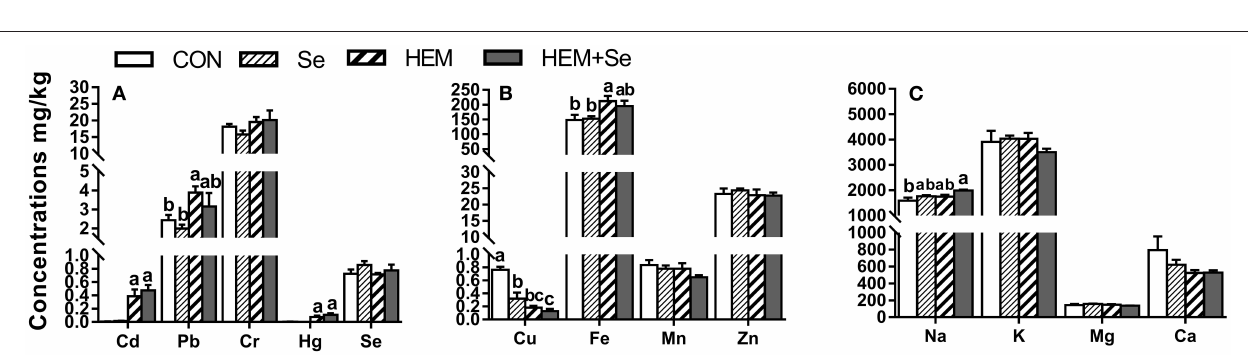
FIGURE 3 | The effect of selenium and cadmium, lead, mercury, chromium Co-treatment on the concentrations of ions in the ovary (Wet Basis mg/kg) of laying hens from 63 to 74 wk of age. CON, corn-soybean meal basal dietary; Se, the basal dietary supplemented with 0.4 mg/kg selenium from selenized yeast (the selenium concentration was 0.14 mg/kg in the CON diet); HEM, the basal dietary supplemented with 5 mg/kg cadmium from CdCl 2 , 50 mg/kg lead from Pb(NO 3 ) 2 , 3 mg/kg mercury from HgCl 2 and 5 mg/kg chromium from CrCl 3 ; HEM + Se, the HEM dietary supplemented with 0.4 mg/kg selenium from selenized yeast. (A) The effect of selenium and cadmium, lead, mercury, chromium Co-treatment on the concentrations of cadmium, lead, chromium, mercury, selenium in the ovary. (B) The effect of selenium and cadmium, lead, mercury, chromium Co-treatment on the concentrations of copper, iron, manganese, zinc in the ovary. (C) The effect of selenium and cadmium, lead, mercury, chromium Co-treatment on the concentrations of sodium, potassium, magnesium, calcium in the ovary. a,b,c Bars without a shared common letter are significantly different ( p < 0.05). Data show the mean ± SEM ( n = 10).